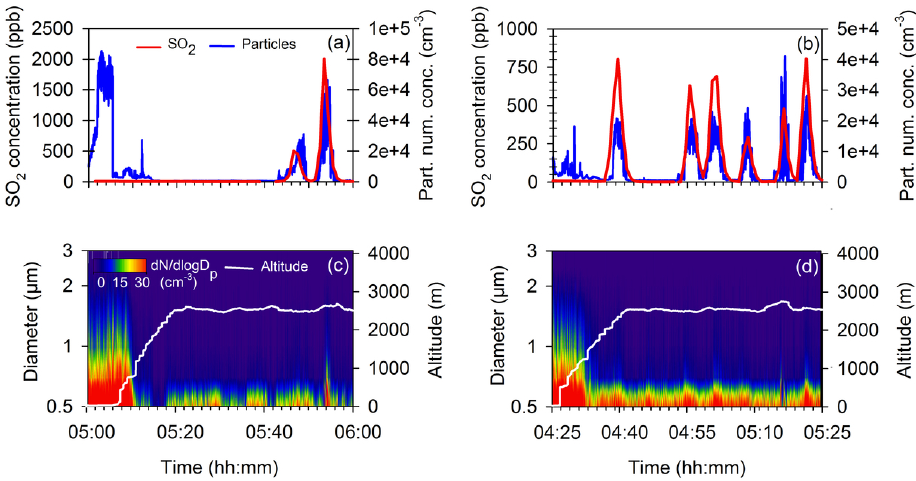
Figure 12. On-board ultralight aircraft measurements sampled on 1 September 2015 (a, c) and 2 September 2015 (b, d) over La Réunion. (a, b) Time series of SO 2 mixing ratio (ppb, red line) and particle number concentration (cm − 3 , blue line). (b, c) Particle number size distribution (colour) and altitude of the aircraft (white line). The trajectories of the flights are pointed out on Fig. 11.